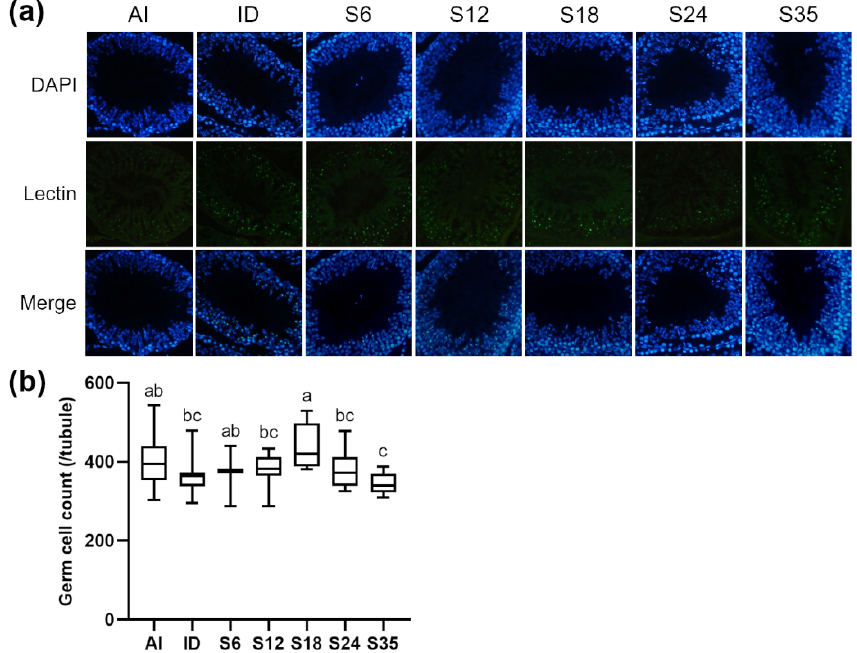
Figure 7. Effects of different doses of iron supplementation on ( a ) testicular seminiferous tubules by DAPI (nucleus) and Lectin (acrosome) staining, and ( b ) germ cell numbers in stage V of spermato- genesis in iron-deficient rats. Values are presented as median (interquartile range, IQR). n = 4 per group. Values not sharing the same letters are significantly different at p < 0.05.